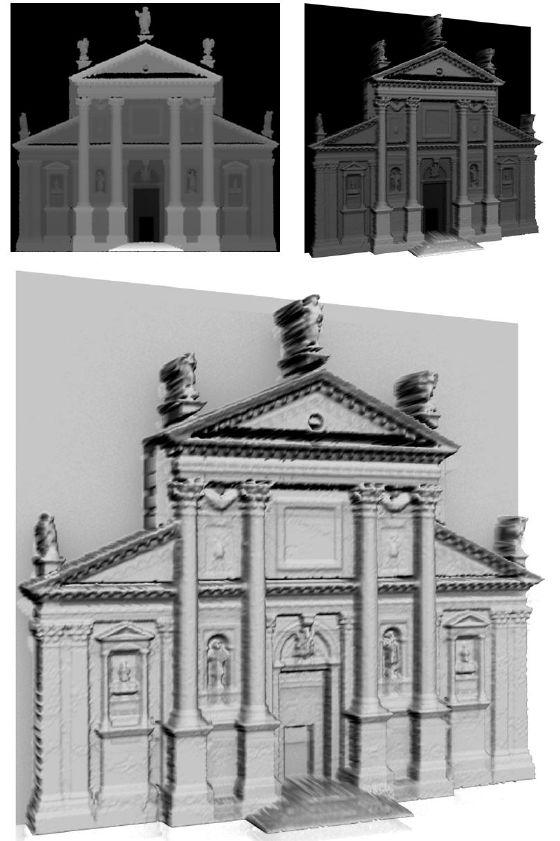
Figure 7. San Giorgio Maggiore in Venice.